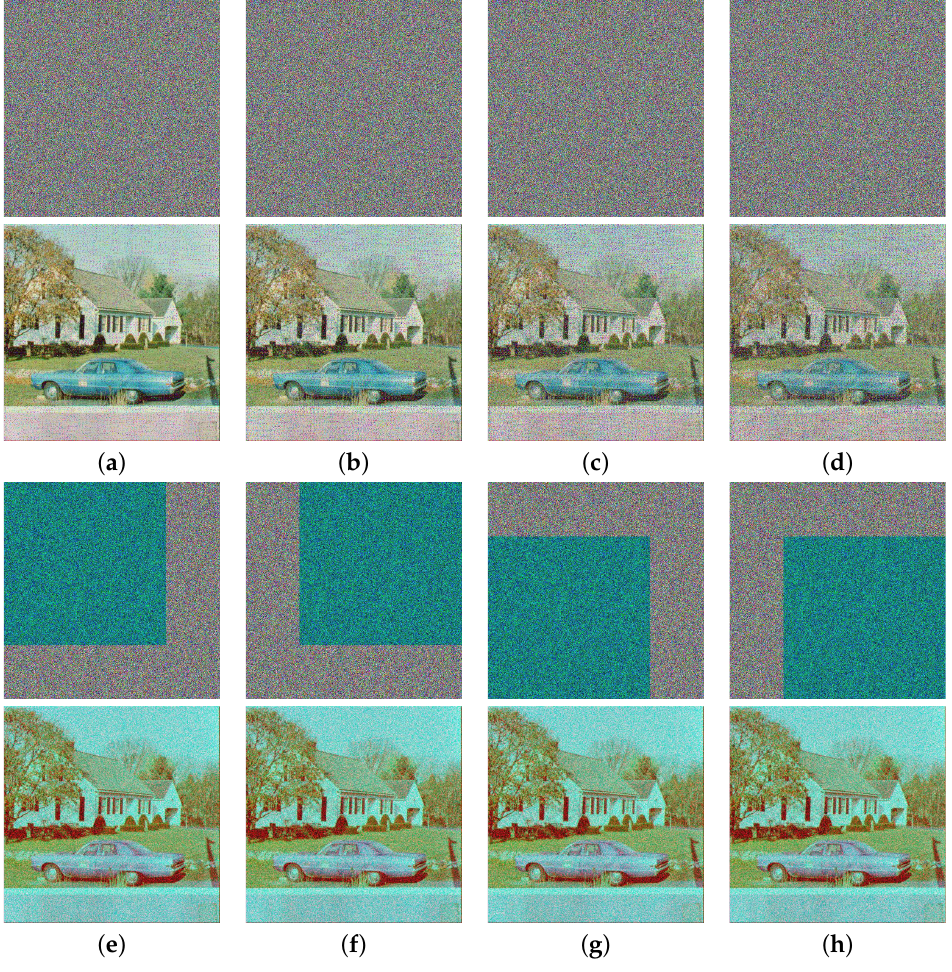
Figure 13. Test results of IEA-IF-DLT in terms of robustness analysis. The first row presents four noise contaminated cipher images, and the second row presents the corresponding decrypted images. The third row shows four cipher images with data loss, and the fourth row shows the corresponding decrypted images. ( a ) intensity of SPN is 0.005; ( b ) intensity of SPN is 0.01; ( c ) intensity of SPN is 0.015; ( d ) intensity of SPN is 0.02; ( e ) data loss at top-left corner; ( f ) data loss at top-right corner; ( g ) data loss at bottom-left corner; ( h ) data loss at bottom-right